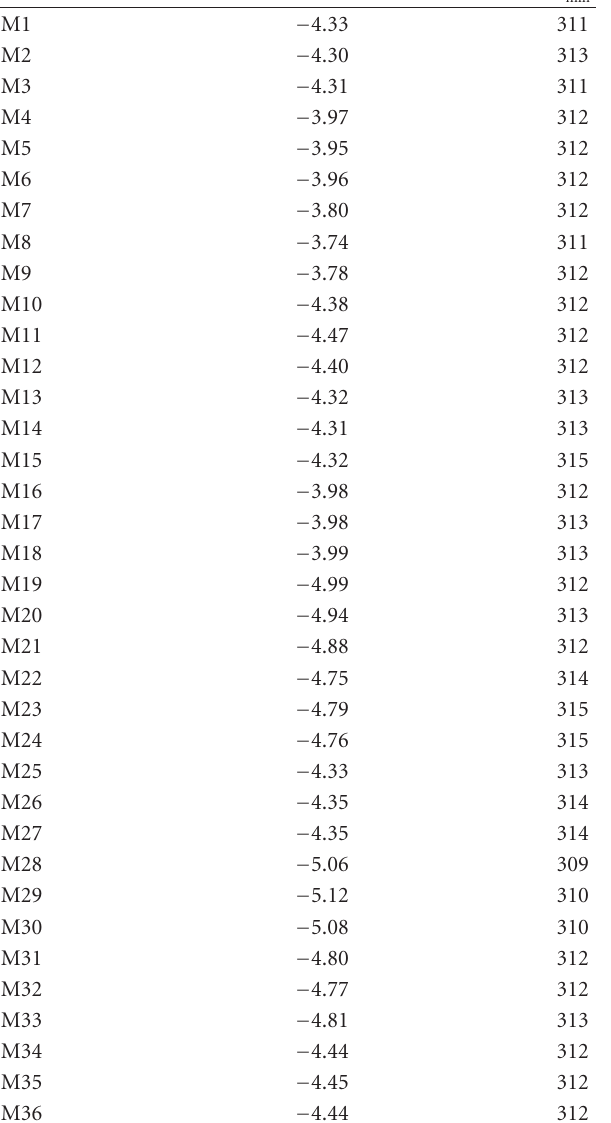
Table 4: Regression coe ffi cient of minimum pressure and pressure di ff erences of Venturi injector.